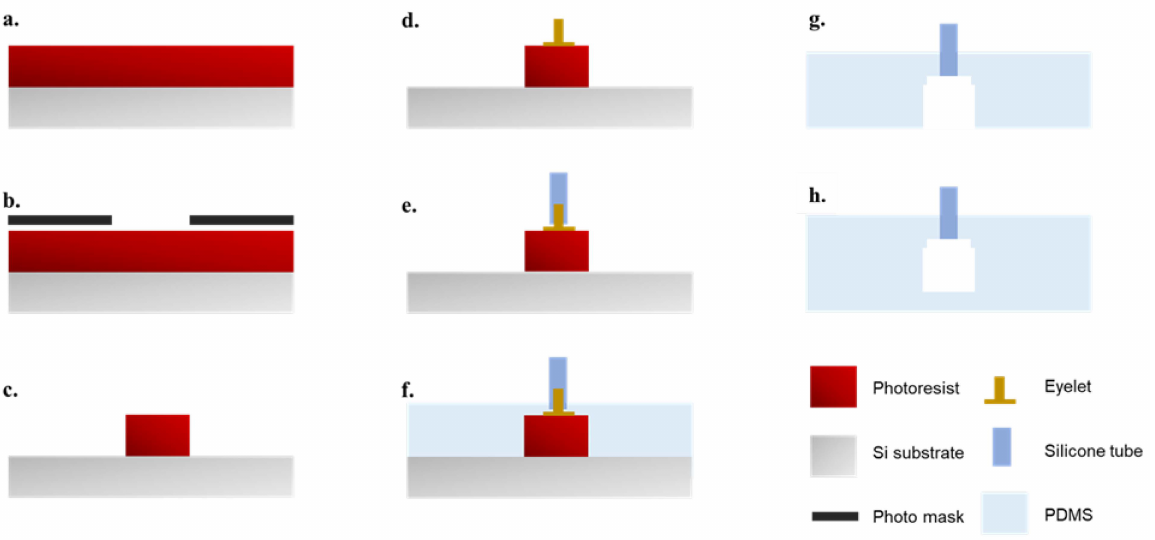
Figure 5. Fabrication process of a microfluidic device. ( a ) Resist coating. ( b ) Exposure. ( c ) Develop- ment. ( d ) Bonding eyelet. ( e ) Fabrication of the inlet and outlet section with silicone tube. ( f ) Pouring PDMS into a mold. ( g ) Removing PDMS from the mold. ( h ) Joining of PDMS sheet and channel.